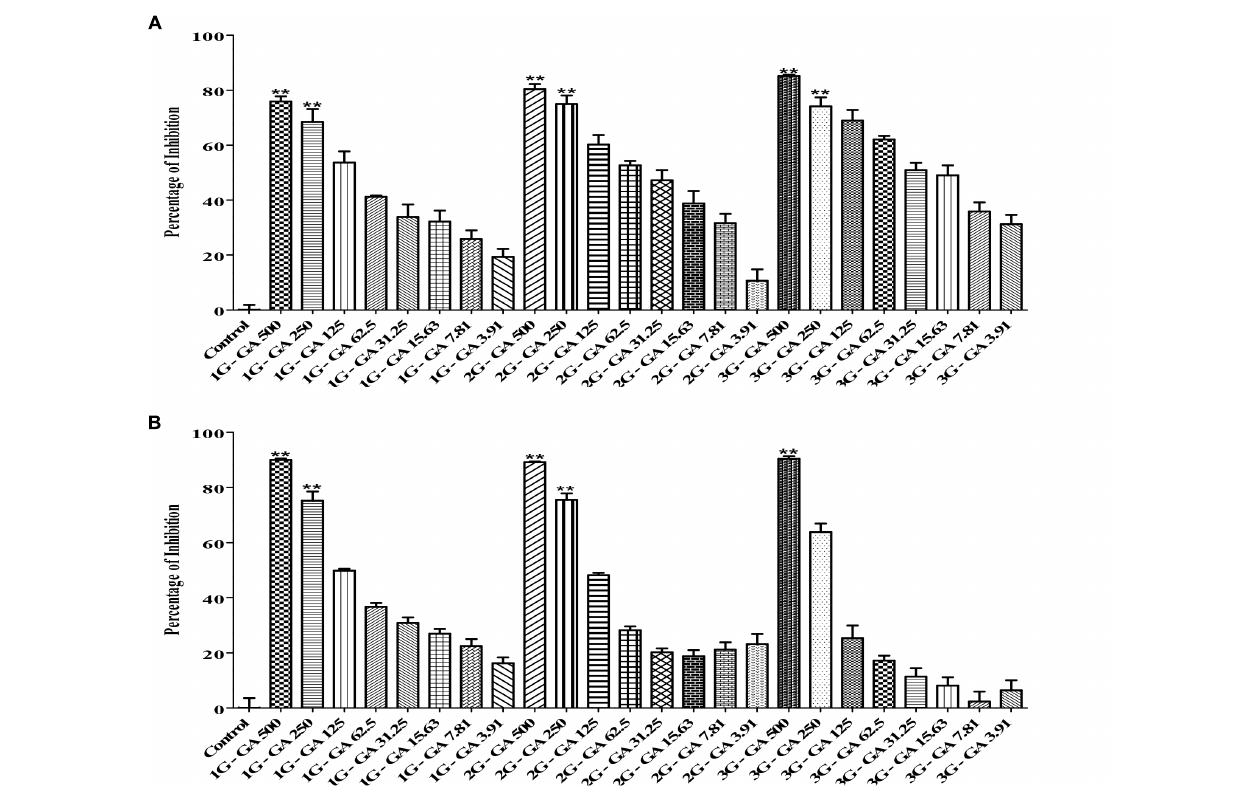
FIGURE 4 | Determination of the MICs of gallic acid against the 1G, 2G, and 3G cell of M. haemolytica (A) and the 1G, 2G and 3G cells of P. multocida (B) , which had been pre-exposed to tulathromycin at 1/2MIC concentration for one, two, and three times, respectively. The concentration of gallic acid was ranging from 3.9 to 500 µ g/mL. One way ANOVA t -test was used for statistical significance. ∗ P -value < 0.05, ∗∗ P- value < 0.01, and ∗∗∗ P -value < 0.001 are shown. Correlation coefficient ( r ) was calculated using Pearson’s correlation method.